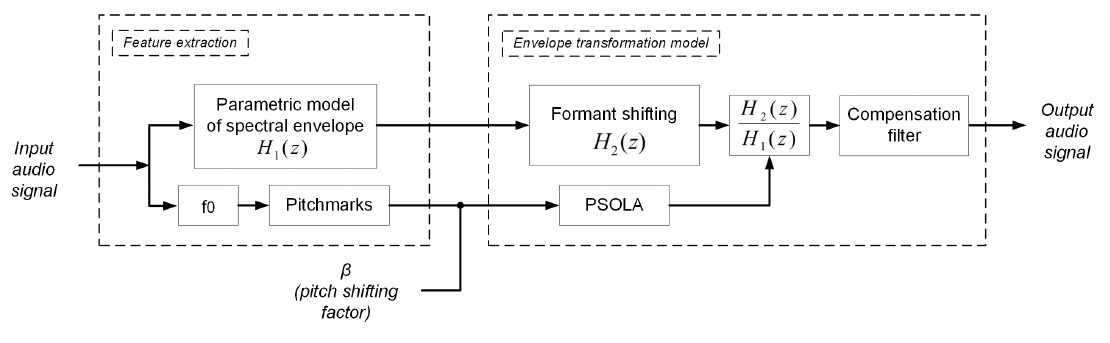
Figure 6. Pitch shifting scheme with envelope